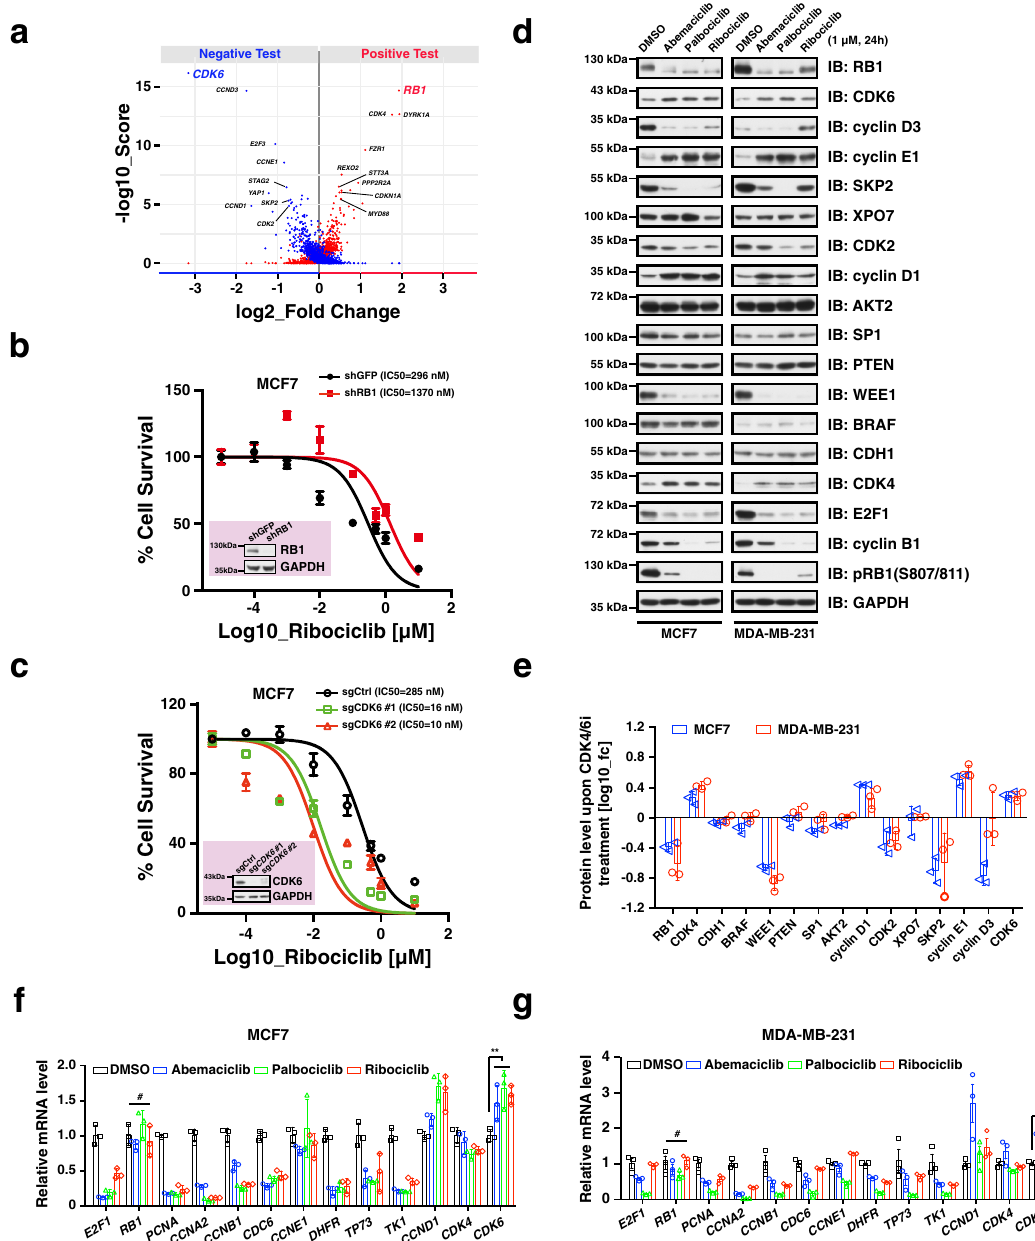
Fig. 1 CDK4/6i treatment leads to dysregulation of RB1 and CDK6 to drive acquisition of CDK4/6i resistance in breast cancer. a Volcano plot showing drivers of CDK4/6i resistance. MCF7 and MDA-MB-231 cells were infected by a pooled CRISPR library. Cells stably expressing sgRNA were then cultured for 21 days in the presence of DMSO and ribociclib (0.5 μ M), respectively. gRNAs at day 0 and day 21 were ampli fi ed by PCR and determined by Illumina deep-sequencing. The P values were based on the empirical Bayes modulated t-statistics. b Knocking-down of RB1 drives resistance of MCF7 cells to ribociclib treatment ( n = 4). c Knocking-out of CDK6 sensitizes MCF7 cells to ribociclib treatment ( n = 4). d Immunoblot showing the protein levels of cell cycle genes in response to CDK4/6i treatment in MCF7 and MDA-MB-231 breast cancer cell lines. e Quanti fi cation of protein intensity of cell cycle genes in ( d ) ( n = 3). The quanti fi cation was performed using ImageJ (1.48 v) software. f RT-qPCR analysis of mRNA levels of indicated cell cycle genes in the context of CDK4/6i treatment (1 μ M, 24 h) in MCF7 breast cancer cells ( n = 3). The P values were calculated by Student ’ s t-test (two-sided). #: no signi fi cance, ** P < 0.01. g RT-qPCR analysis of mRNA levels of indicated cell cycle genes in the context of CDK4/6i treatment (1 μ M, 24 h) in MDA-MB-231 breast cancer cells ( n = 3). The P values were calculated by Student ’ s t-test (two-sided). #: no signi fi cance, ** P < 0.01. Data are presented as mean values ± SEM. The relevant raw data and uncropped blots are provided in Source Data. proteasomal degradation of RB1. As all of those three FDA our study by using ribociclib. Taken together, these results approved CDK4/6 inhibitors (abemaciclib, palbociclib and indicate that upon CDK4/6 inhibitor treatment, RB1 protein ribociclib) displayed similar ability in driving RB1 degradation abundance is reduced while CDK6 protein levels are accumu- and CDK6 upregulation (Fig. 1d – g), and ribociclib showed- lated, a process that may promote therapeutic resistance to these greatest speci fi city for CDK4 22 , we performed the rest of inhibitors. NATURE COMMUNICATIONS| (2021) 12:5386